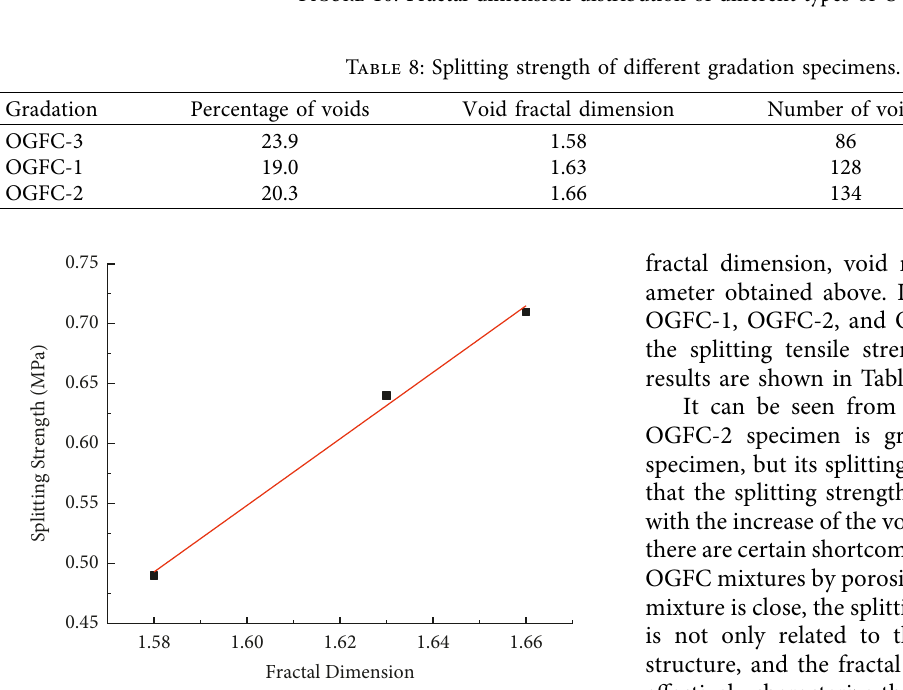
Figure 11: Relationship between the splitting strength and void fractal